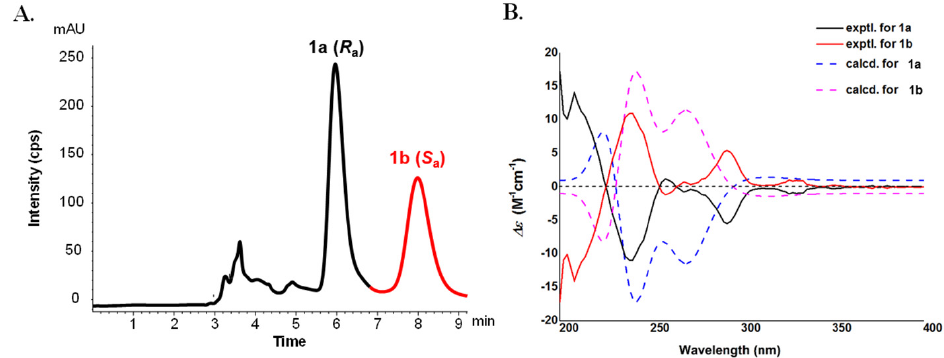
Considering the high steric hindrance at the central biaryl axis of C-8–C-8’’, 1 was supposed to be with an axial chirality. However, its specific rotation value approached zero and no Cotton effects were observed in its ECD spectrum, suggesting 1 to be a pair of atropisomers coexisting as a racemic mixture. Compound 1 was isolated by a chiral HPLC with n -hexane-isopropanol (85:15, v / v , 1 mL/min) as the mobile phase to give the enantiomers 1a and 1b in an approximate ratio of 1:1. Their specific rotations were de- tected as [𝛼] (cid:2888)(cid:2870)(cid:2873) –74 ( c 0.1, MeOH) for 1a and [𝛼] (cid:2888)(cid:2870)(cid:2873) +84 ( c 0.1, MeOH) for 1b , respectively. The ECD spectrum of 1a exhibited a sequential negative and positive Cotton effect at 245 nm and 218 nm, i.e., a negative couplet derived from the electronic transition of the two carbazole monomers, indicating an ( R a ) con fi guration for ( − )-microphyltrine A ( 1a ) and, accordingly, the configuration of (+)-microphyltrine A ( 1b ) was defined as ( S a ) [14]. Fur- thermore, the ECD spectra of ( R a )- and ( S a )- 1 were calculated using the TDDFT method at the B3LYP/6-311G(d) level to confirm the results of ECD exciton coupling. The computed ECD spectrum of ( R a )- 1 matched well with the experimental curve for 1a and the com- puted ECD spectrum of ( S a )- 1 matched well with the experimental curve for 1b (Figure 3). This is the second report for trimeric carbazole alkaloids from a natural source, for the first was murratrines A and B from M. tetramera [4], whose units are three simple carba- zoles linked with a bismethylene ether and a C-3-methyl-linked mode. Figure 2. Key HMBC correlations of compounds 1 , 5 , 15 , and 17 .